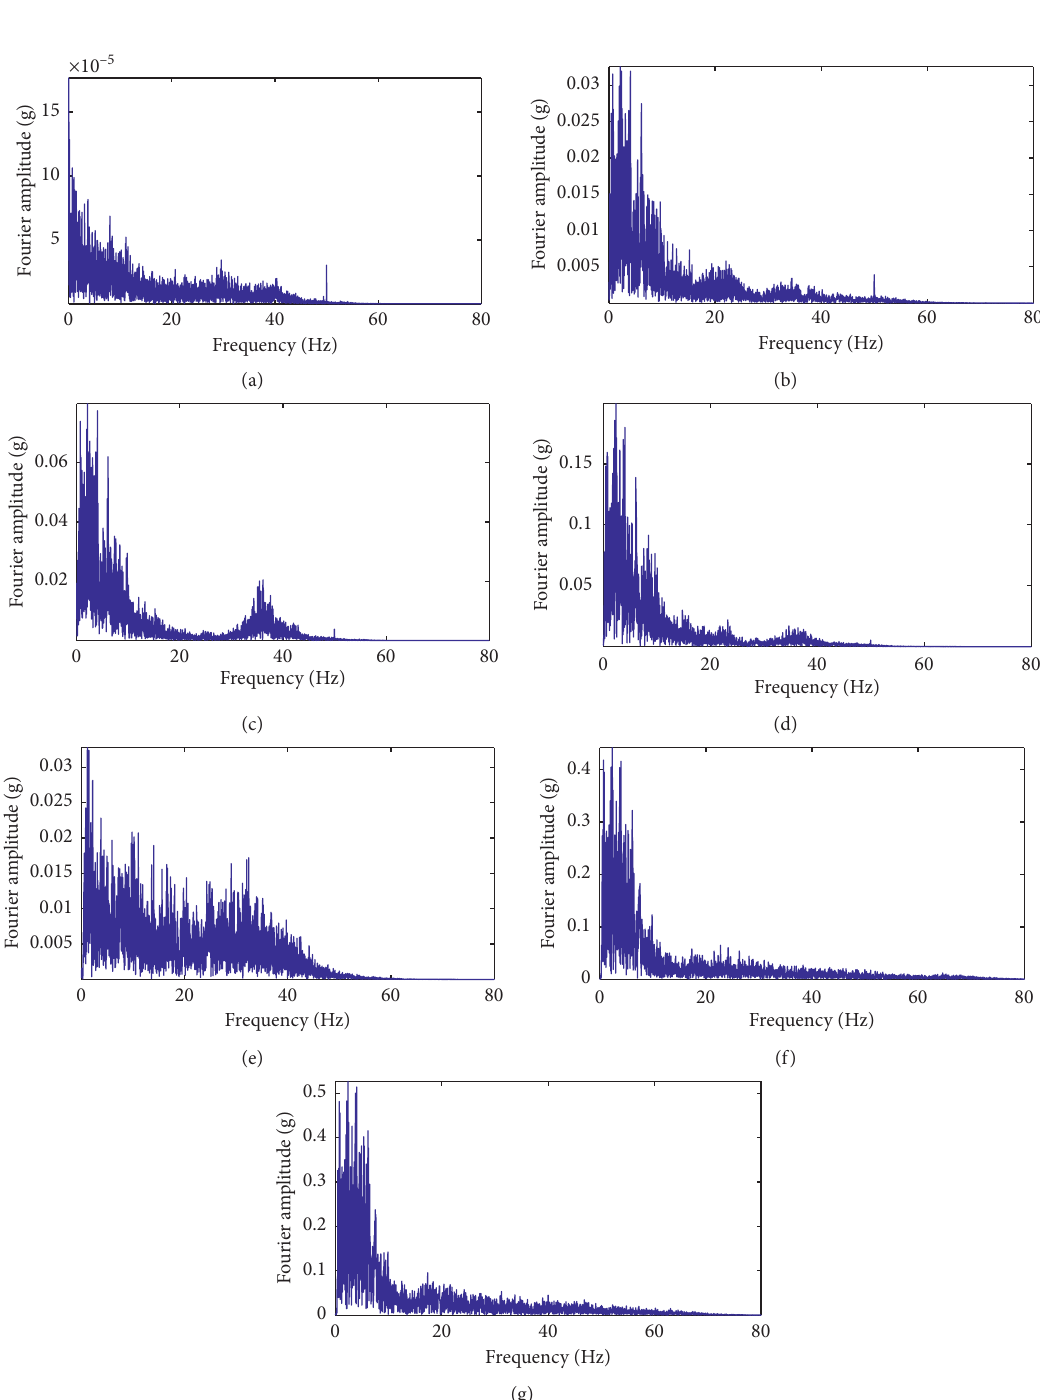
Figure 12: Fourier spectrum of accelerations at measuring point A104 under different PGAs. (a) 0.025g · XY. (b) 0.05 g · XY. (c) 0.1g · XY. (d) 0.2g · XY. (e) 0.3g · XY. (f) 0.4g · XY. (g) 0.5g ·